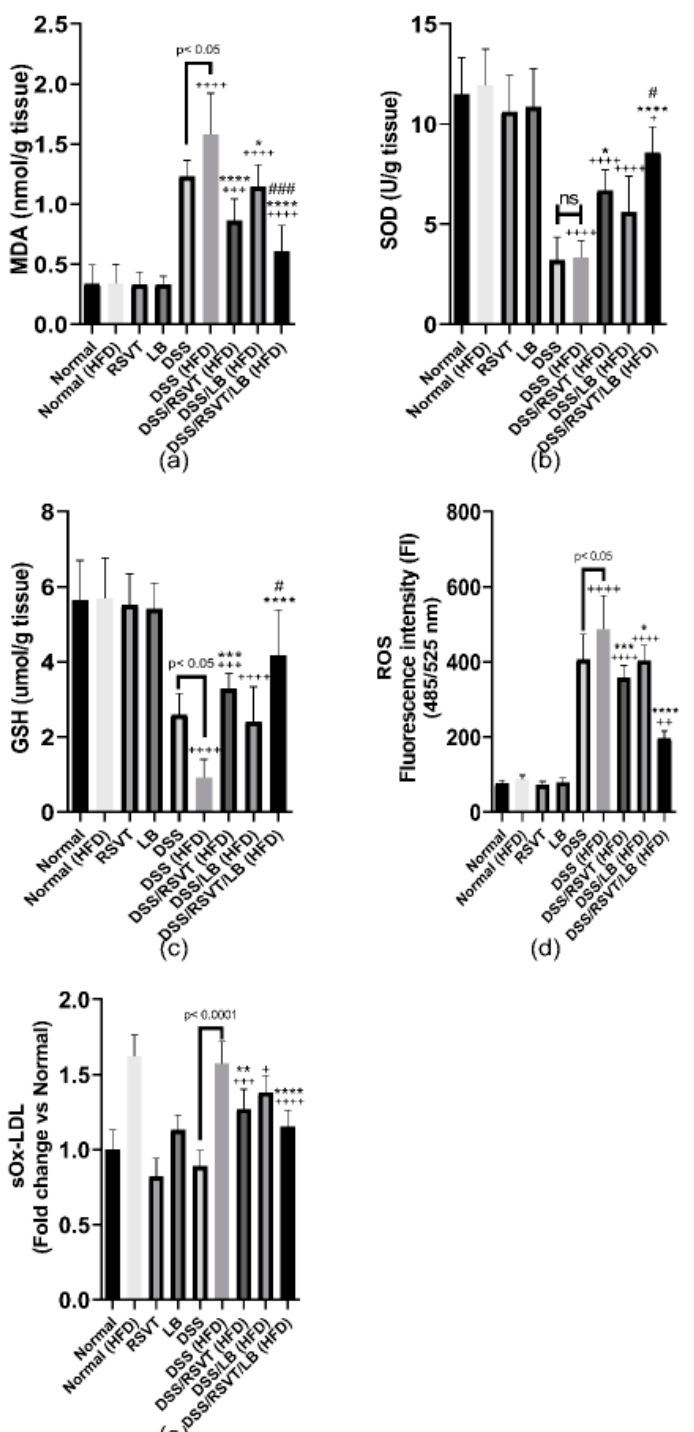
Figure 6. Effect of rosuvastatin (RSVT), Lactobacillus (LB), and their combined therapy on ( a ), Malondialdehyde (MDA); ( b ), superoxide dismutase (SOD); ( c ), reduced glutathione (GSH); ( d ), reactive oxygen species (ROS); and ( e ), soluble oxidized low-density lipoprotein (sOx-LDL). +, p < 0.05 vs. Normal (HFD); ++, p < 0.01 vs. Normal (HFD); +++, p < 0.001 vs. Normal (HFD); ++++, p < 0.0001 vs. Normal (HFD); *, p < 0.05 vs. DSS (HFD); **, p < 0.01 vs. DSS (HFD); ***, p < 0.001 vs. DSS (HFD); ****, p < 0.0001 vs. DSS (HFD); #, p < 0.05 vs. DSS/LB (HFD); ###, p < 0.001 vs. DSS/LB (HFD); ns, non-significant.